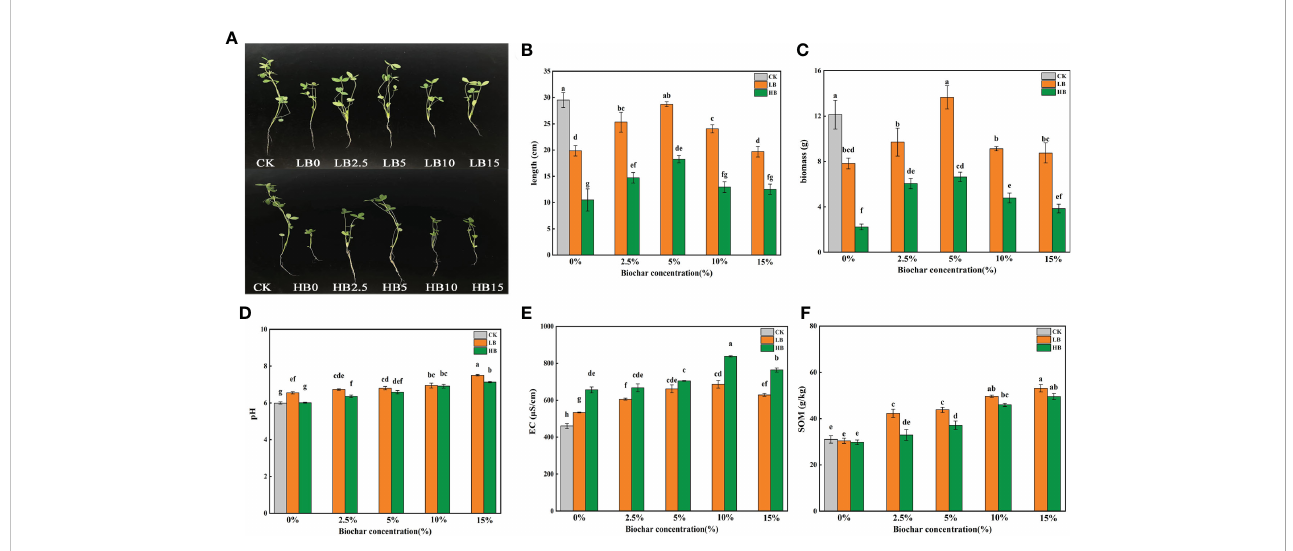
FIGURE 1 Effects of CSB at different concentrations on (A, B) shoot length of red clover, (C) biomass of red clover, (D) rhizosphere soil pH, (E) EC and (F) SOM under Pb toxicity. Different small letters indicate signi fi cant differences under different Pb concentration treatments and different biochar doses